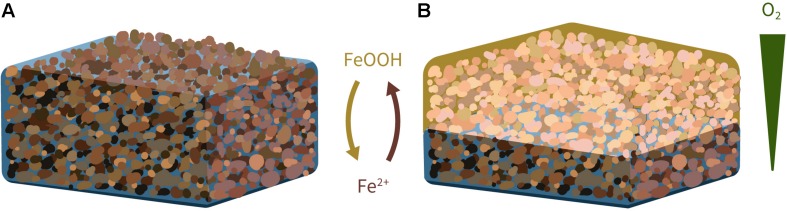
Conceptual model of microbial iron cycling for cementation of crushed canga in a post-mining context. Provision of an abundant and appropriate carbon source will promote effective reduction of crystalline iron oxides in a saturated pile of crushed canga, e.g., during wet season (A), while evaporation, e.g., during the subsequent dry season, will drive oxidation of the ferrous iron rich fluids as the oxidation front progresses downward (B). Neutrophilic iron-oxidizing bacteria will likely play a role at the redox front (Roden et al., 2004).